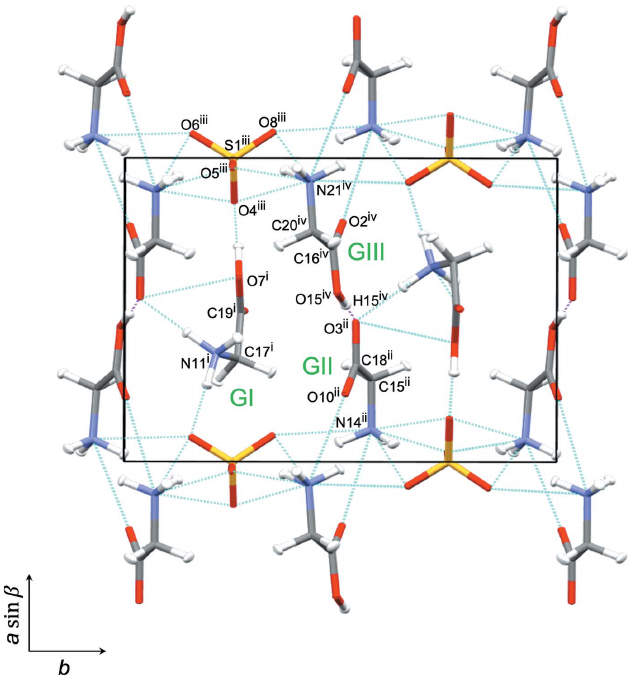
Figure 2 [001] projection of the unit cell of HTGS at 20 K with hydrogen bonds shown as dashed lines. The O15—H15 (cid:2)(cid:2)(cid:2) O3 hydrogen bonds are shown as pink dashed lines. Glycine molecules are represented as glycine I (GI), glycine II (GII), and glycine III (GIII), according to Hoshino et al. (1959). Symmetry codes: (i) (cid:3) 1 + x , y , 1 + z ; (ii) (cid:3) 1 + x , y , z ; (iii) 1 (cid:3) x , 1 (iv) 2 (cid:3) x , (cid:3) 1 + y , 2 (cid:3) z 2